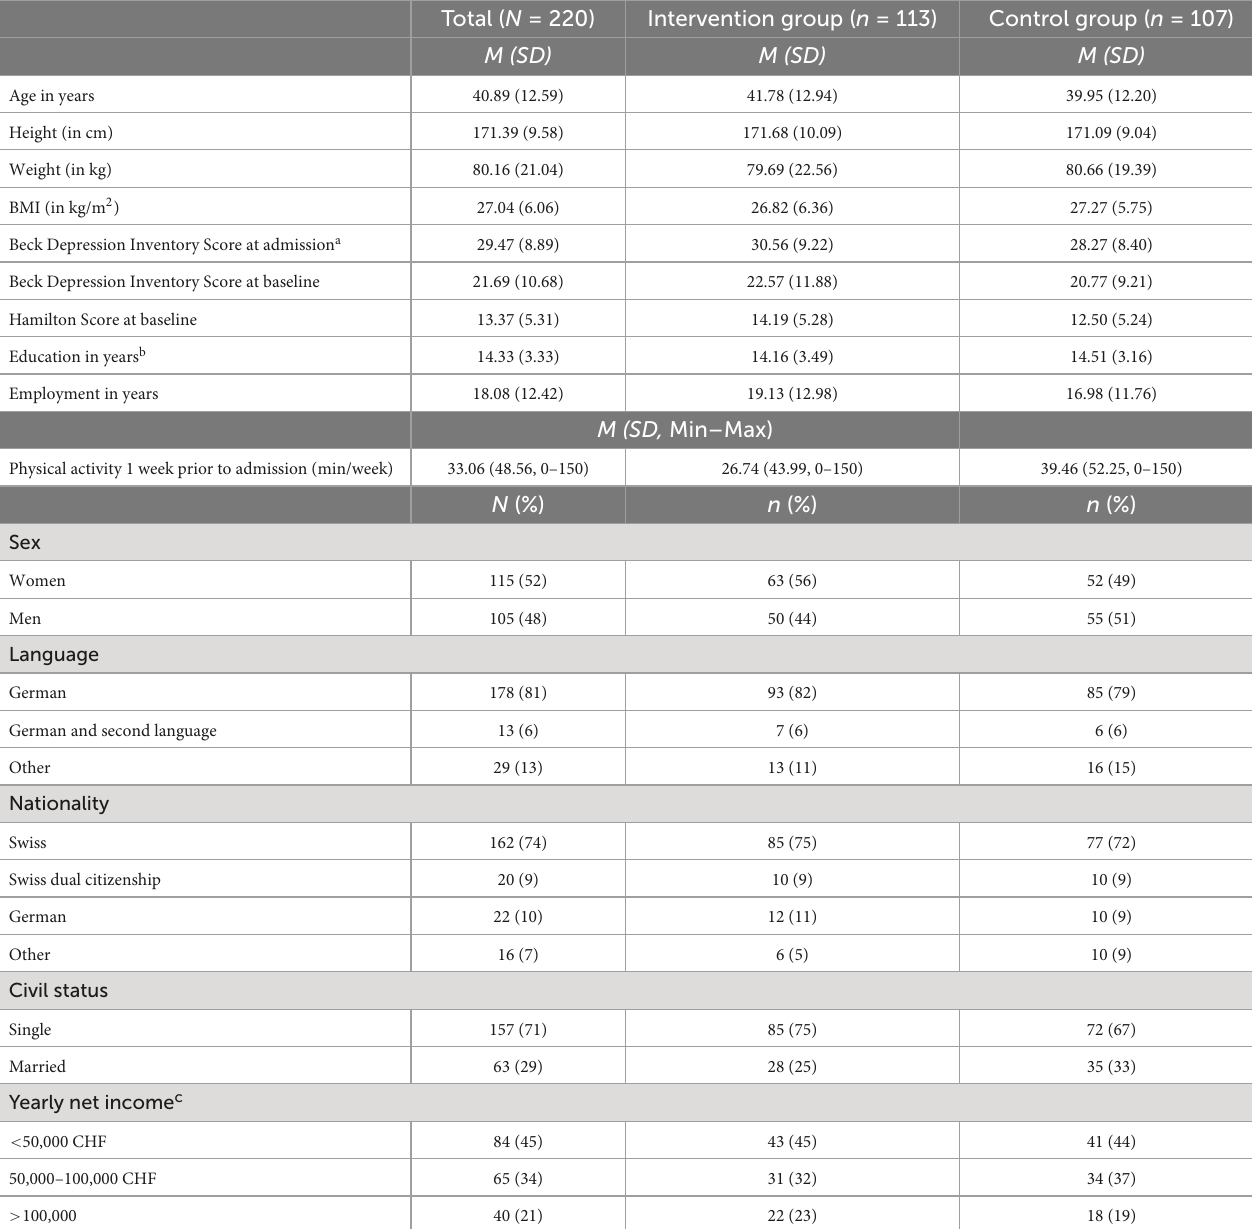
TABLE 1 Participant